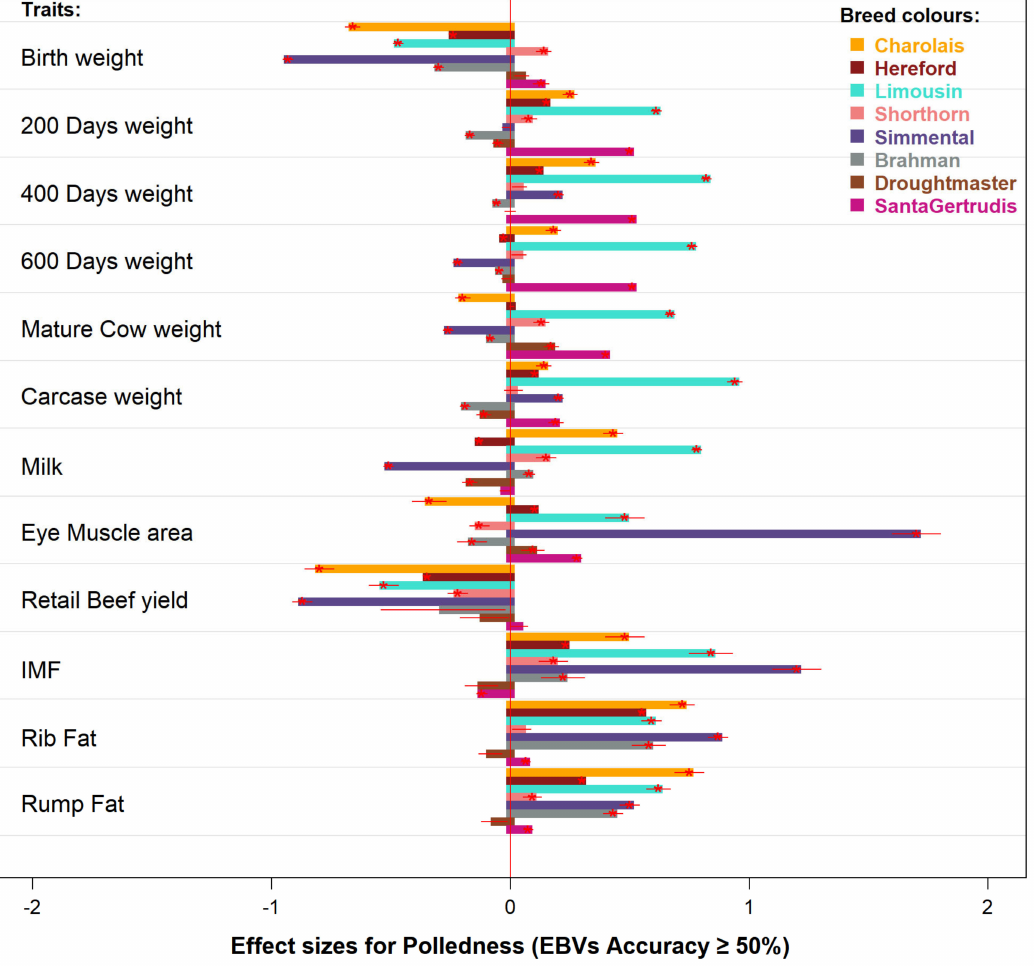
Figure 7. Effect sizes (Cohen’s d ) of polledness in 8 breeds using BREEDPLAN EBVs (accuracy ≥ 50%) on 12 production traits. Red lines within each bar show 95% confidence intervals of effect sizes. Statistically significant results are shown with a red star. An effect size indicates how much the two cohort means differ by a d standard deviation. A positive value indicates higher genetic merit for polled